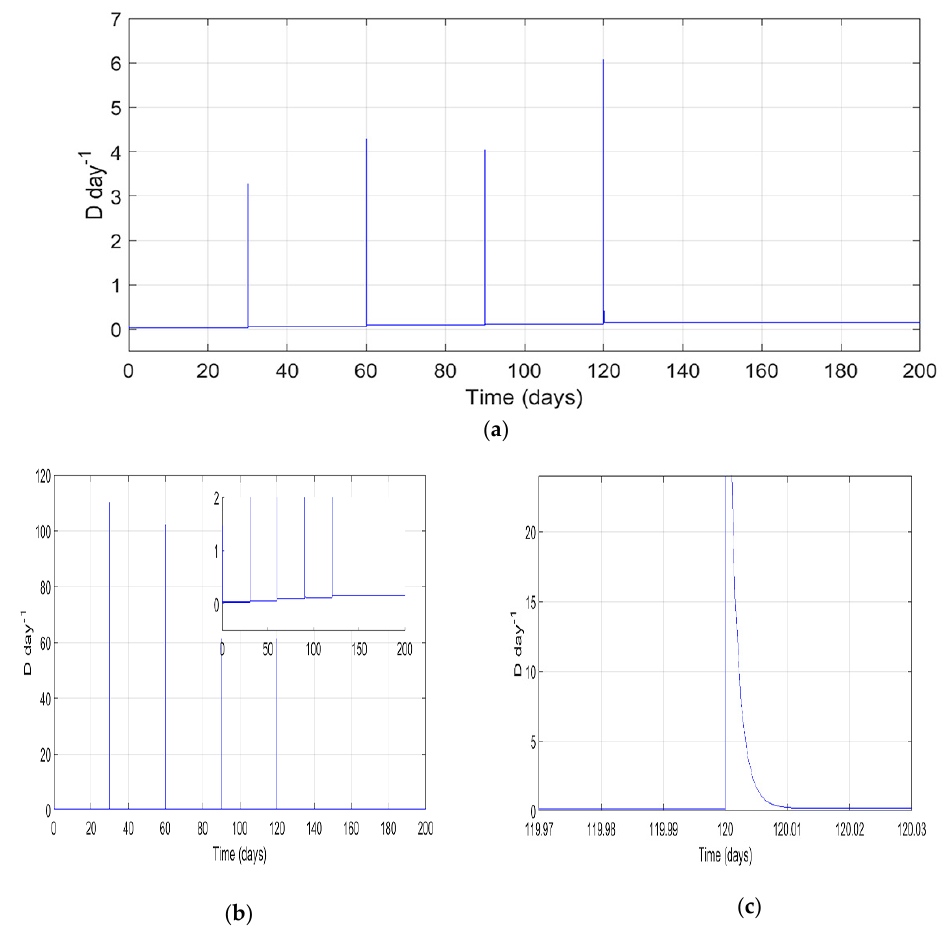
Figure 3. Control signal evolution ( a ) under synergetic control for T = 0.01 ( b ) under PID control ( c ) under PID control zoomed